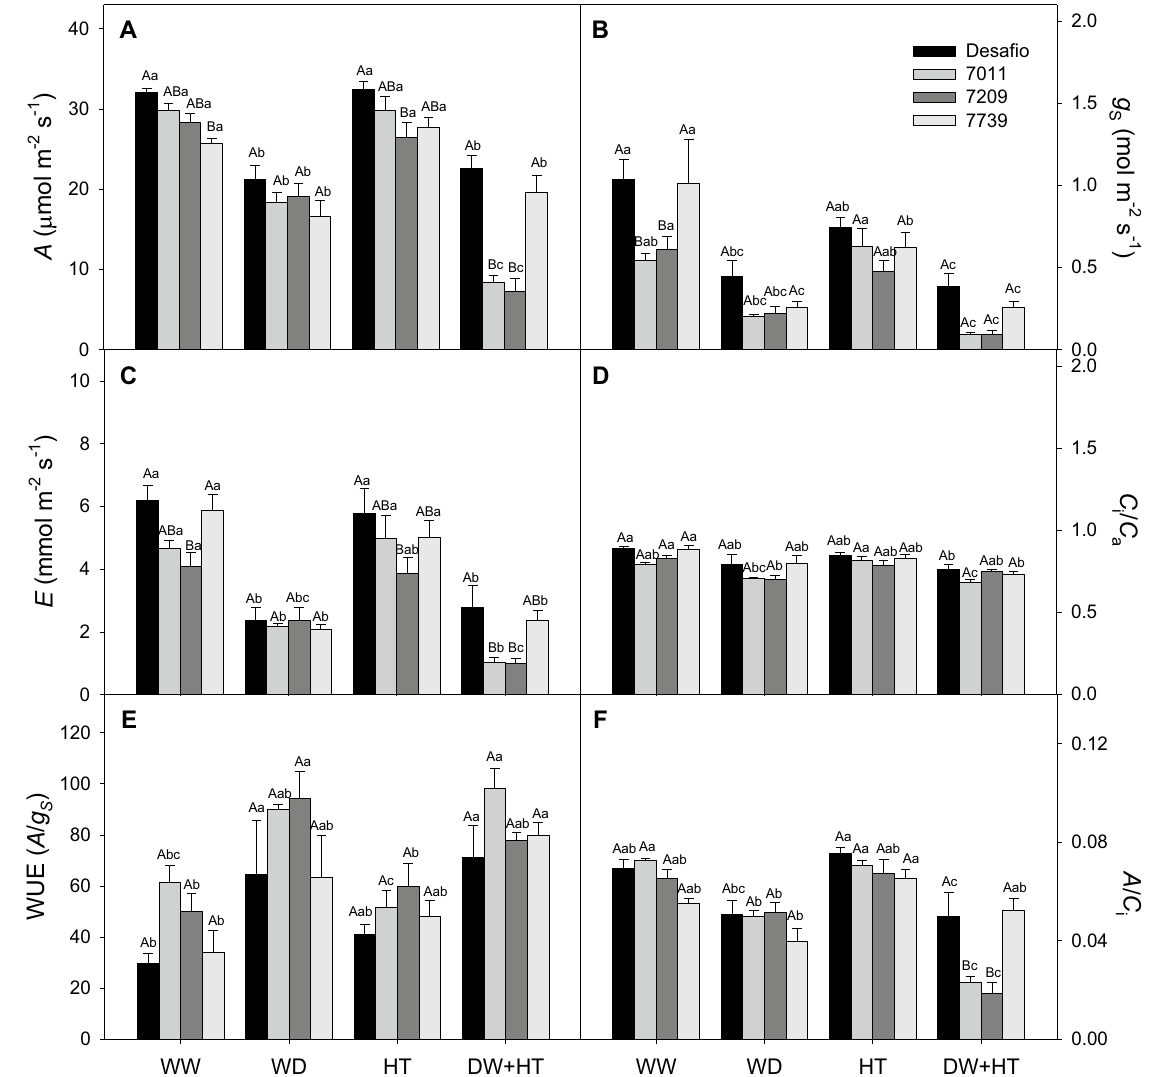
Figure 2. Gas exchange parameters of soybean plants maintained for 8 days under well-watered (WW; 100% holding water capacity HWC, 25 °C), water deficit (WD; 40% HWC, 25 °C), high temperature (HT; 100% HWC, 40 °C), and water deficit plus high temperature (WD + HT; 40% HWC; 40 °C) conditions. ( A ) Photosynthetic rate ( A , µmol m −2 s −1 ). ( B ) Stomatal conductance ( g s , mol m −2 s −1 ). ( C ) Transpiration rate (( E ), mmol m −2 s −1 ). ( D ) Intrinsic water-use efficiency (WUE = A / g s ). ( E ) Ratio of internal and external CO 2 concentration ( C i /C a ). ( F ) Instantaneous carboxylation efficiency ( A / C i ,). Bars represent mean ± SE ( n = 5). Means followed by the same uppercase letters compare cultivars within the same water and temperature treatment. Means followed by the same lowercase letters compare water and temperature treatments within the same cultivar, as determined by the Tukey test at 5% of